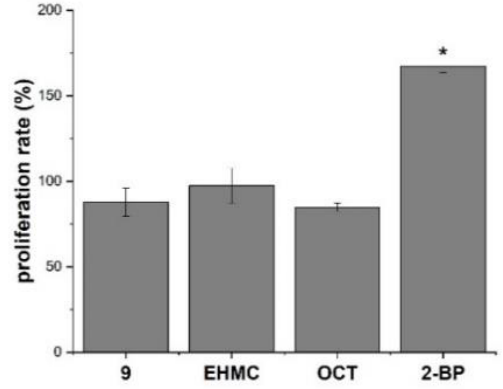
Figure 8. Proliferation rate ( ± SD) of MCF-7 cells incubated with tested compounds at 5 µ M. Com- pound 9 , EHMC, and OCT showed lack of proliferation-stimulating effect. BP-2 increased MCF-7 proliferation by over 60% (*—data significantly different from control, p <